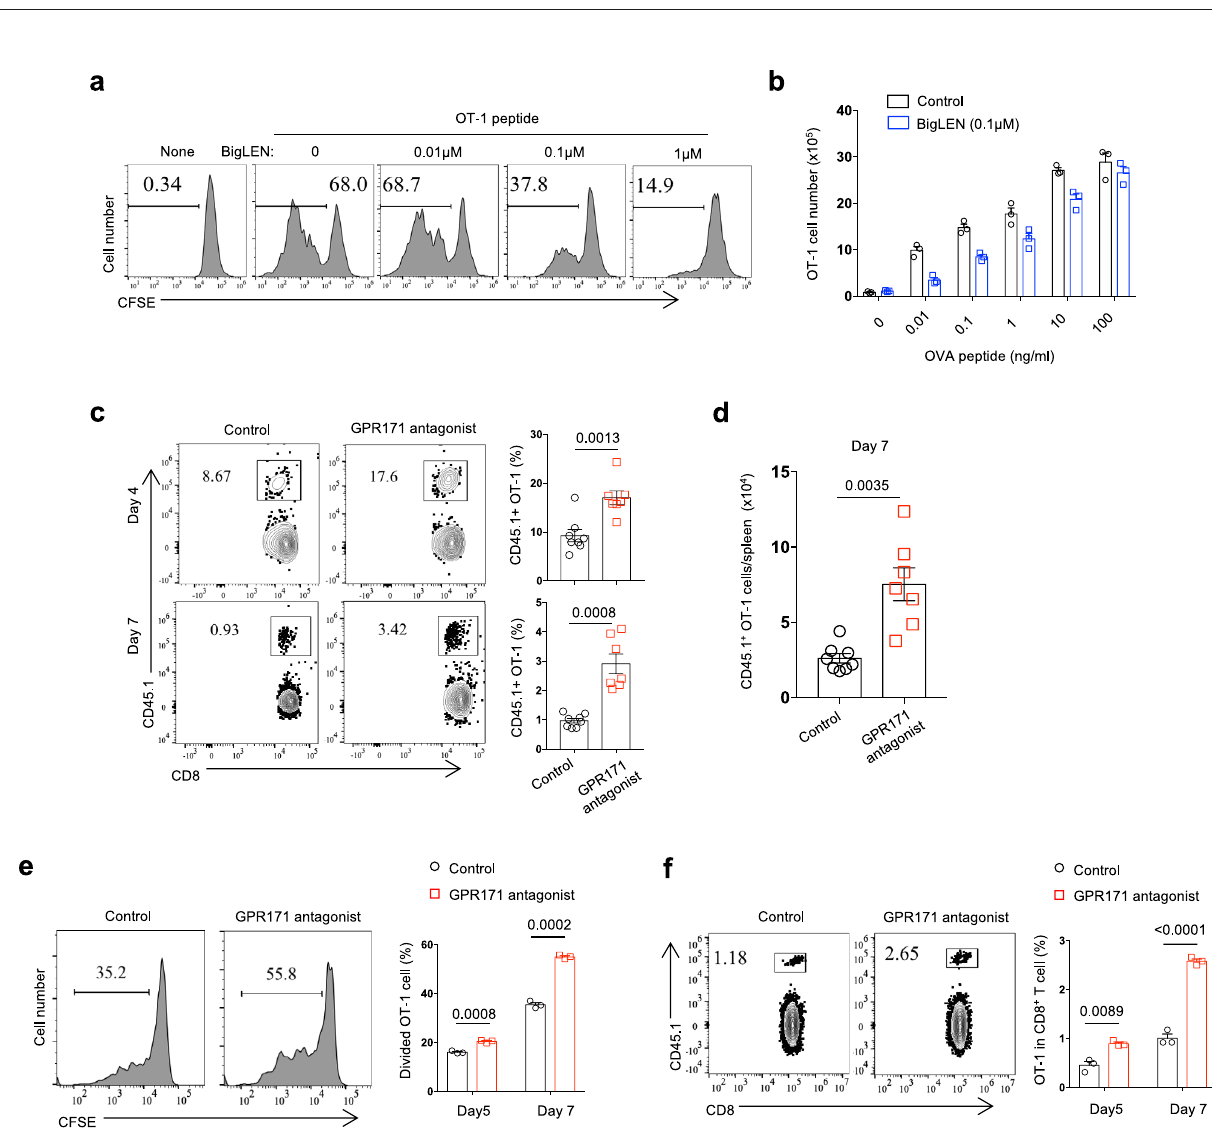
Fig. 2 The BigLEN/GPR171 interaction inhibits mouse T-cell response. a , b CFSE-labeled naive OT-1 T cells were stimulated with different concentrations of SIINFEKL peptide for 6 days. The percentages of divided OT-1 cells ( a ) and the numbers of live OT-1 cells ( b ) were determined by fl ow cytometry. c , d B6 mice transferred with naive CD45.1 + OT-1 T cells were immunized with OT-1 peptide and followed with the treatment of GPR171 antagonist. Transferred OT-1 T cells in peripheral blood at 4 and 7 days after peptide injection were examined by fl ow cytometry ( c ). The number of CD45.1 + OT-1 T cells in the spleen at 7 days after injection was enumerated ( d ). e , f B16-OVA bearing mice were transferred with CFSE-labeled CD45.1 + naive OT-1 T cells and followed with the treatment of GPR171 antagonist. 5 and 7 days after OT-1 transfer, the divisions ( e ) and percentages ( f ) of transferred OT-1 T cells in dLNs were determined. c , d n = 8 (control) and n = 7 (GPR171 antagonist) biologically independent samples. e , f n = 3 biologically independent samples. Statistical signi fi cance was determined by two-tailed Student ’ s t -test for c , d , e , f . Unless otherwise denoted, values are mean ± SEM. Source data was provided as a Source Data fi le. All data are representative of two independent